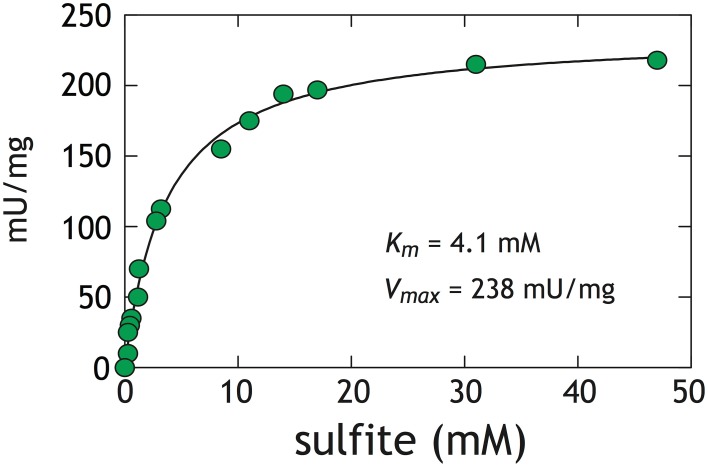
Activity assays with D. vulgaris DsrAB. The difference between initial and final concentration of sulfite after 2 h was used to calculate the rate. The Michaelis-Menten equation (Y=Vmax×XKM+X) was solved for experimental Km and Vmax under our conditions. The analytical error is less than the size of the symbols (2σ = 1μM). One unit (U) is defined as the quantity of enzyme that catalyzes the conversion of one micromol of substrate per minute. At both 10 and 15 mM initial sulfite we are assured to be well above the apparent DsrAB Km for sulfite. Reaction inhibition was not observed at sulfite concentrations as high as 50 mM (Wolfe et al., 1994; Soriano and Cowan, 1995).